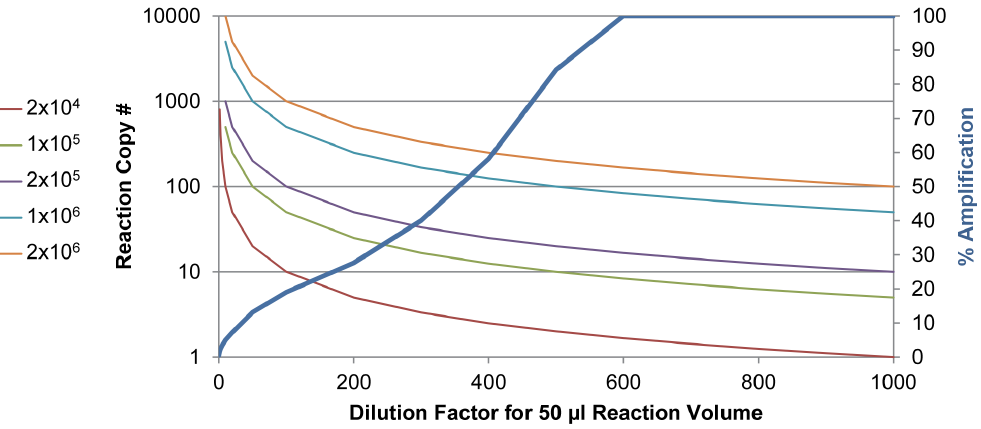
Figure 3. Model describing low copy number non-detection for dilutive methods. The right hand Y-axis (% amplification) shows the increase in amplification associated with dilution of inhibitors from a fecal sample. A range of starting target concentrations (CFU/gram) is plotted with the left hand Y-axis showing the copy number present in a 50 m l reaction volume (Illumigene). The reduced inhibition and increasing % amplification with increasing dilution is concomitant with a reduction in copy number. At lower CFU/gram samples, the dilution places the copy number per reaction beneath the sensitivity of the assay. HE-LAMP-BART used a 50 fold dilution together with the inhibitor removal such that a higher copy number can be present in the reaction.